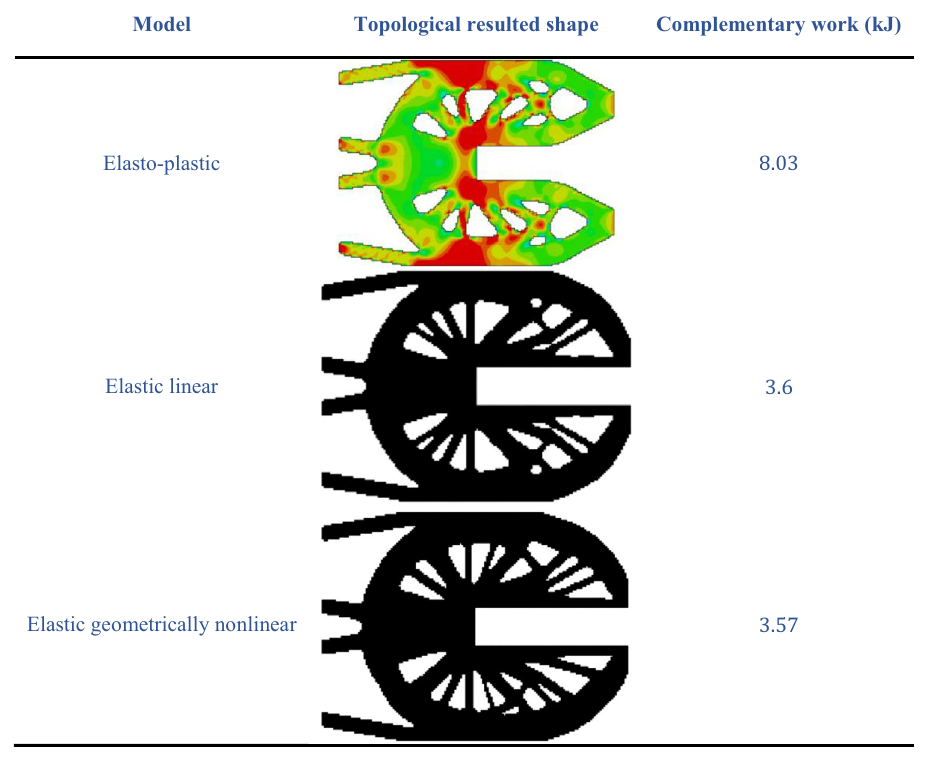
Table 11. Design results and complementary work values of the U-shape models.